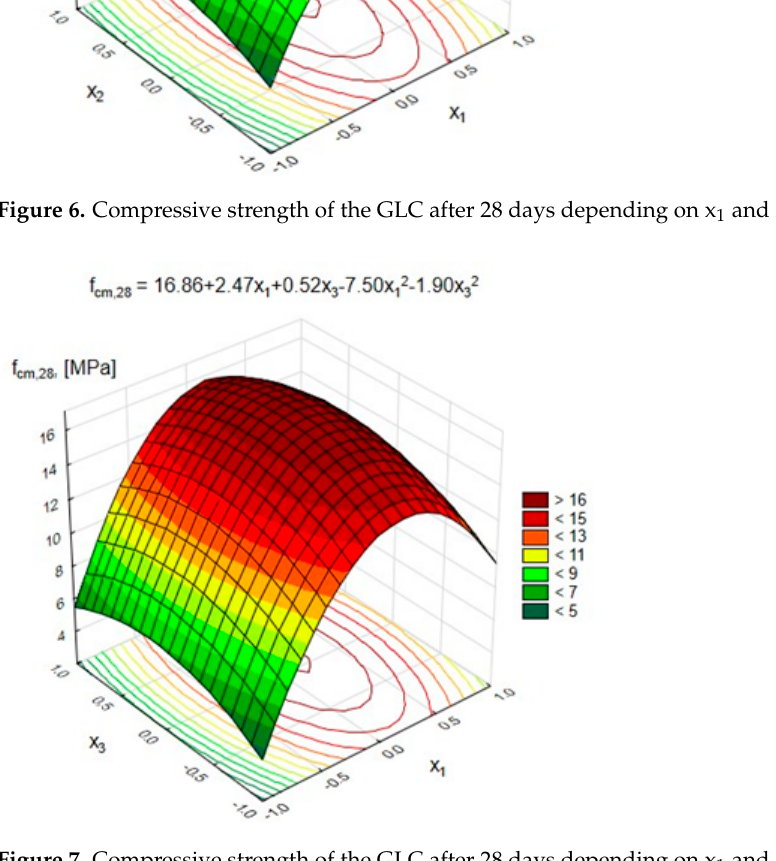
Figure 7. Compressive strength of the GLC after 28 days depending on x 1 and x 3 with x 2 = 0 (50%).